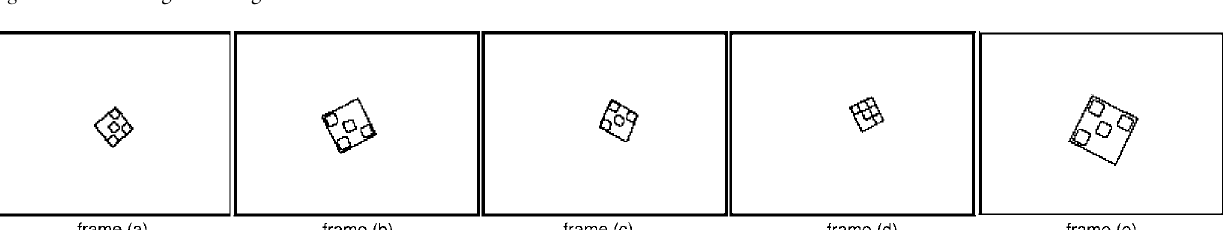
Figure 12 Five original images.